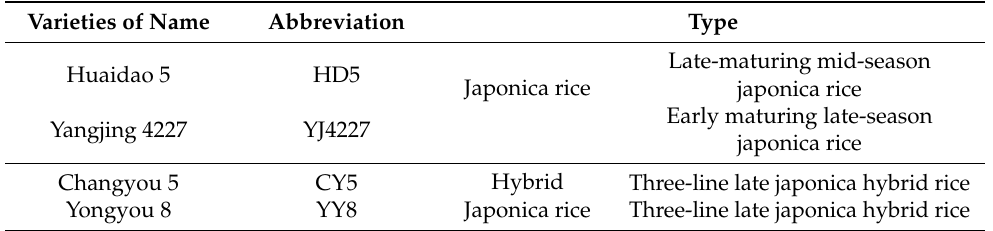
Table 3. The varieties tested.